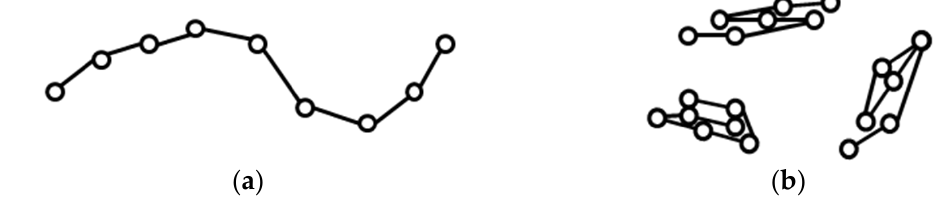
Figure 3 . Acrylic polymer macromolecules in a neutral medium (closer to pH = 5–6)—( a ); in an acidic medium—( b ) (pH < 1).